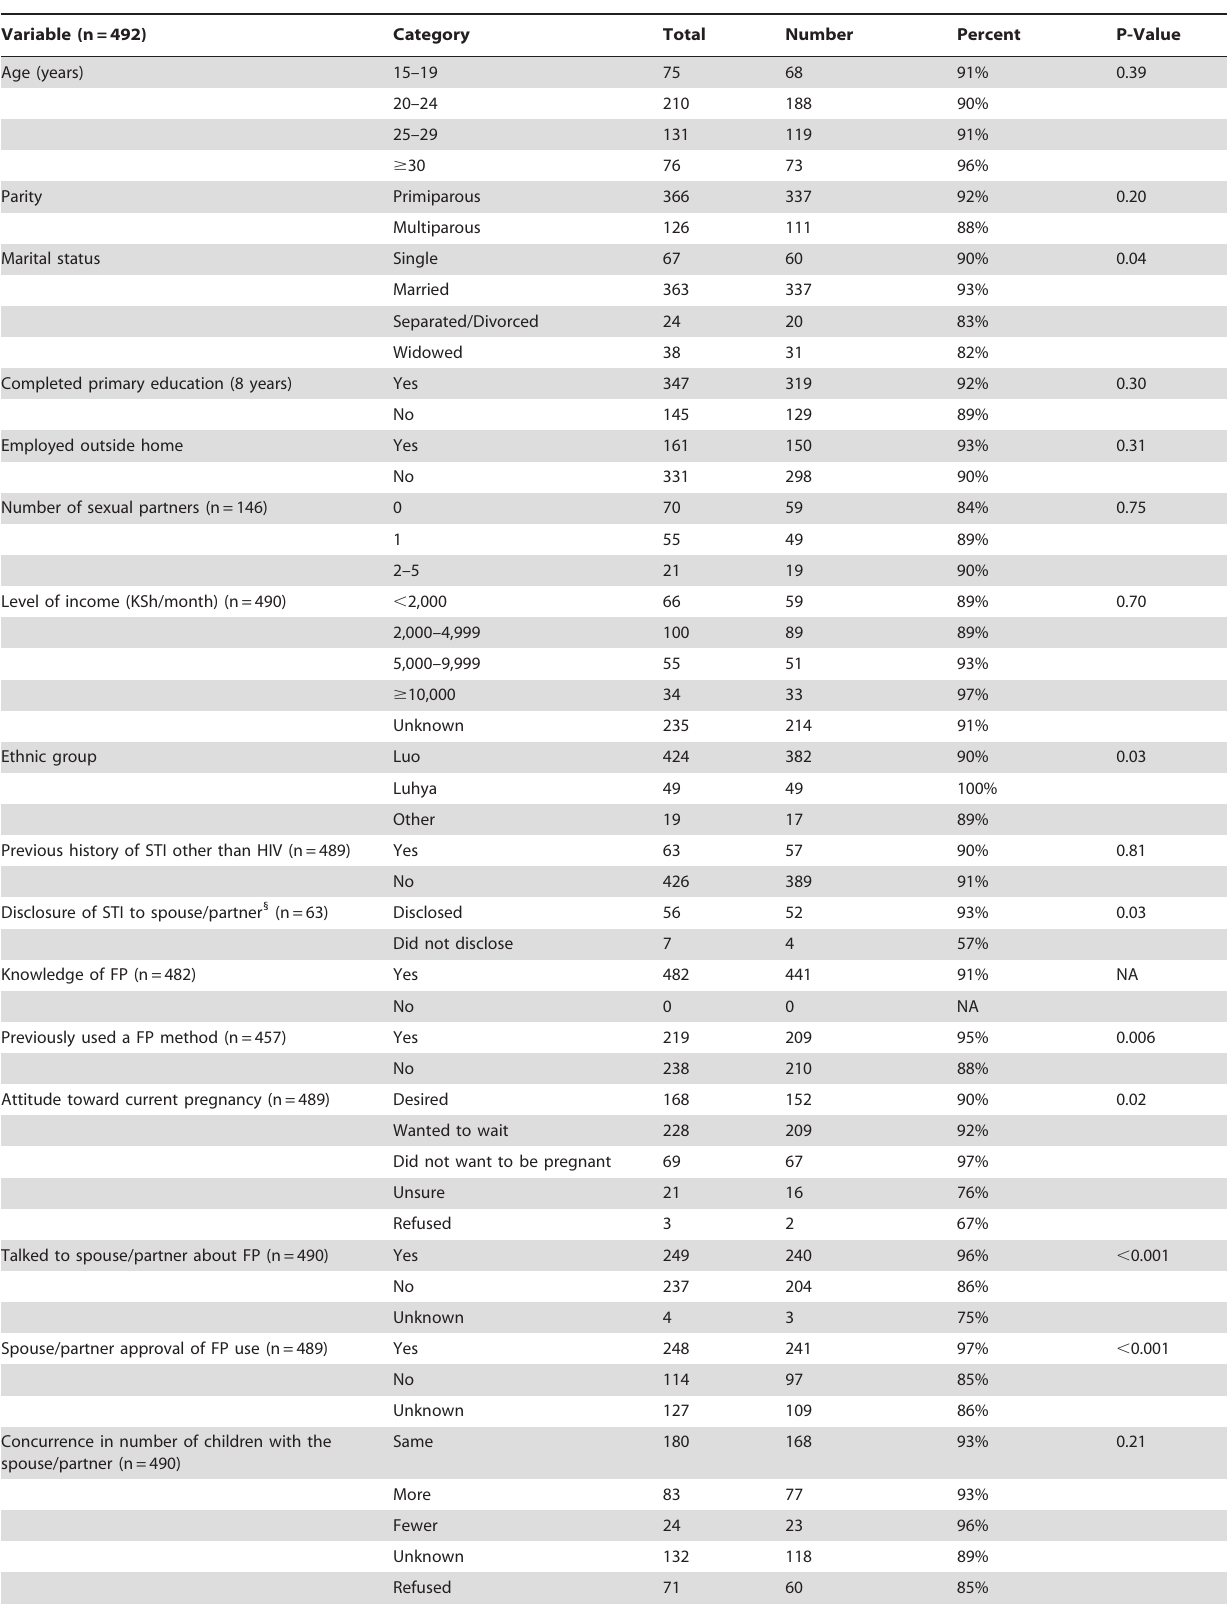
Table 3. Predictors of Intention to Use Family